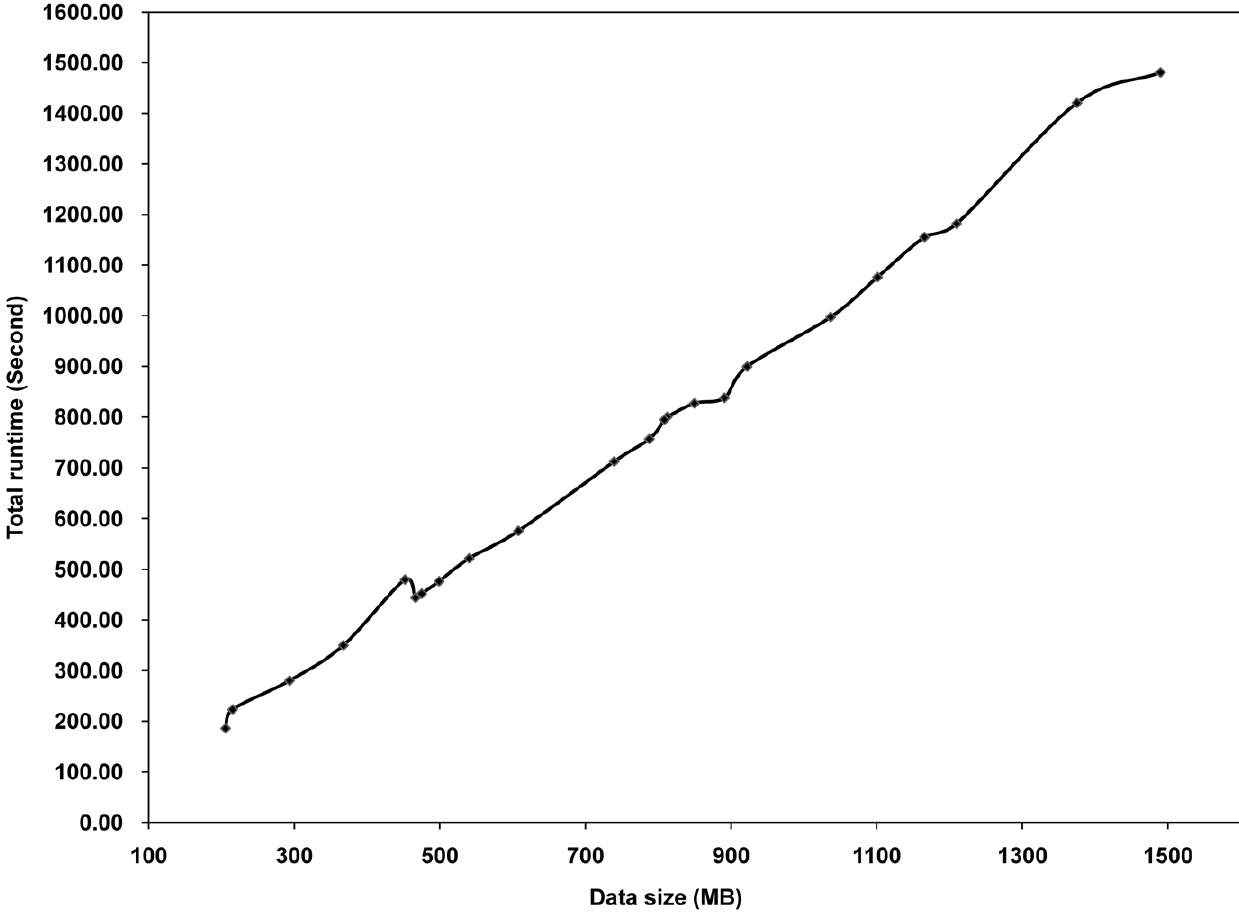
Figure 7. Runtime of MGVD for 40 high resolution aCGH samples. The entire runtime increased linearly with increasing data size. During the runtime, MGVD generated CNVZs and CNVs for each sample.